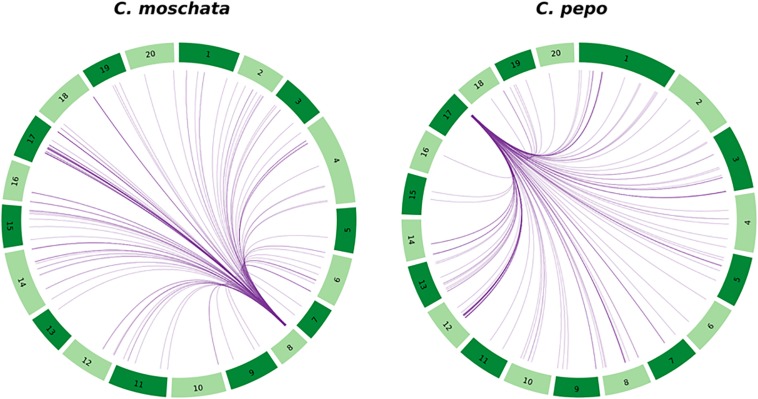
Circos plot showing the location of the duplicated genes located in C. moschata’s candidate region of chromosome 8 and in C. pepo’s syntenic region to C. moschata located in chromosome 17.